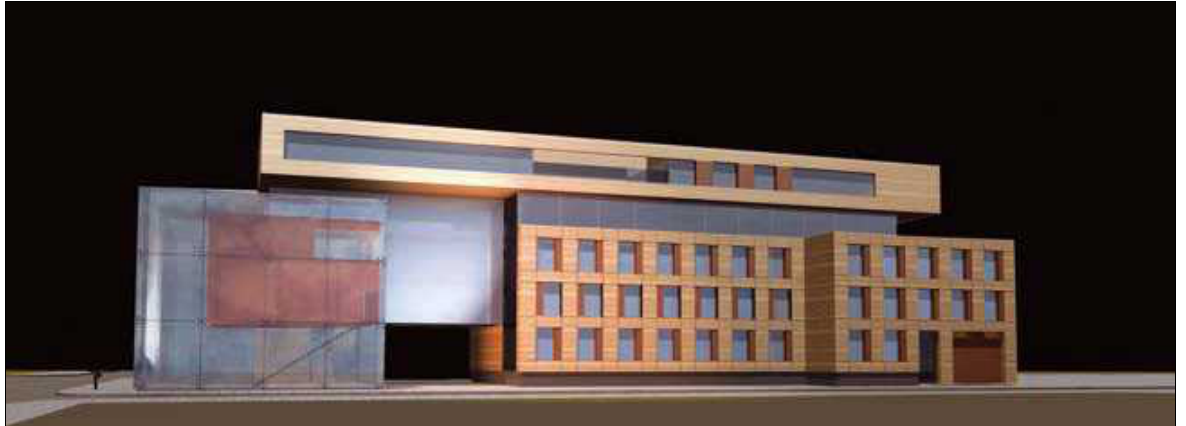
Fig. 6. a­b “a­chema“ centr­al office in Vilniu­s. a­r­chitects t. Pau­lau­skas, s­. Pamer­neckis, t. Mazūr­as. Model